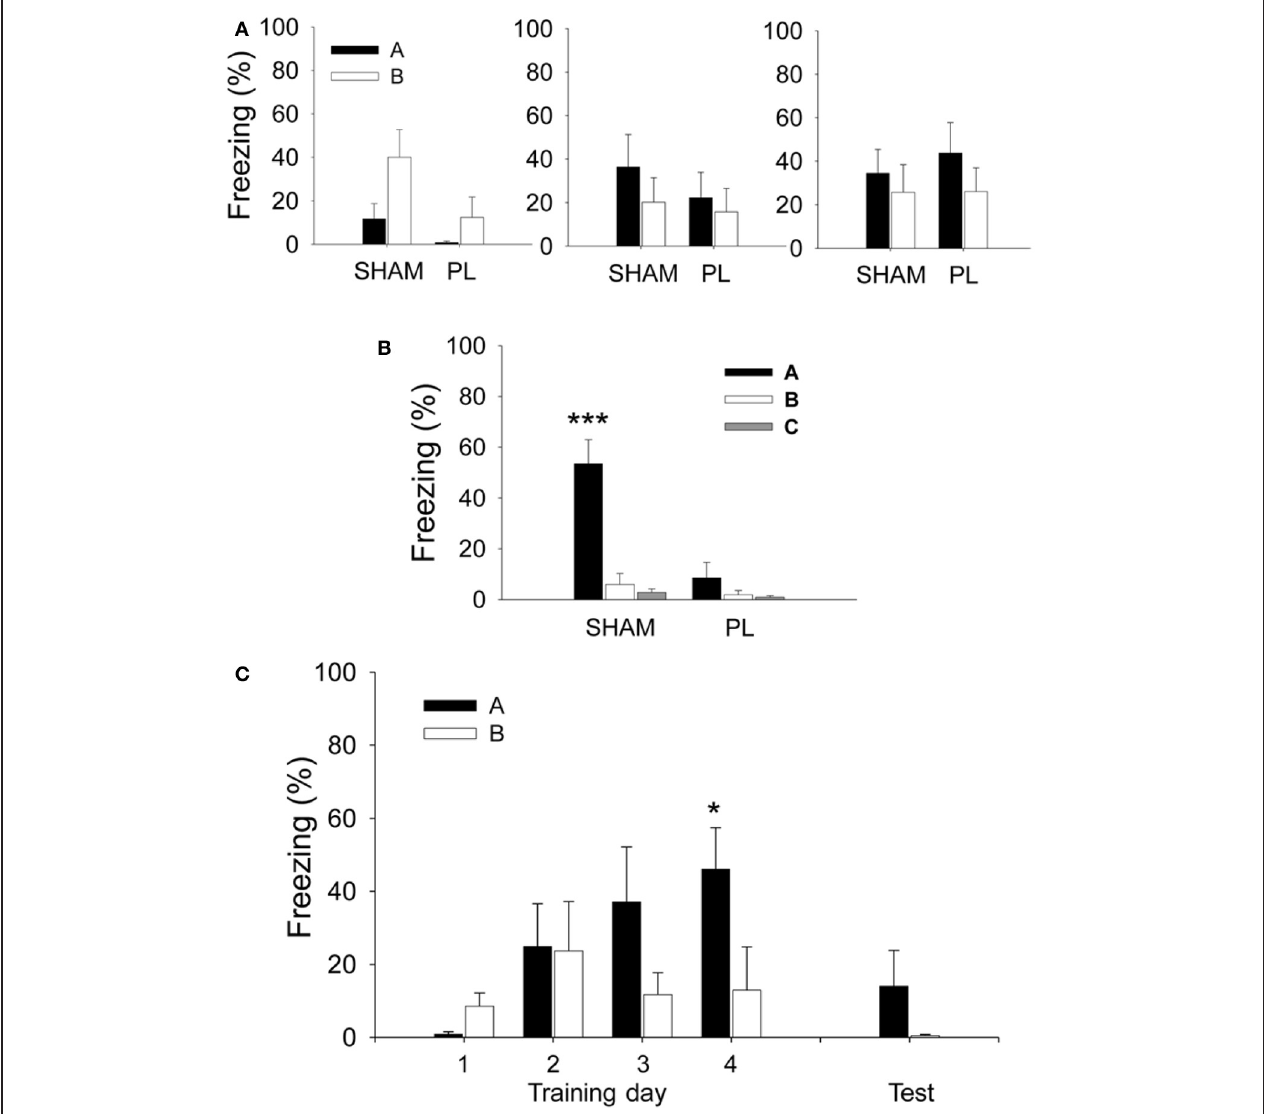
FIGURE A2 | Mean percentage of freezing during the pre-tone period before the presentation of the first CS. (A,B) In the lesion experiment, both SHAM and PL lesion groups showed a similar level of pre-tone freezing across the 3 days of training (A) . However, on the test session (B) , the SHAM group developed a pre-tone response that discriminates Context A from other contexts, as opposed to the PL lesion group which continued to